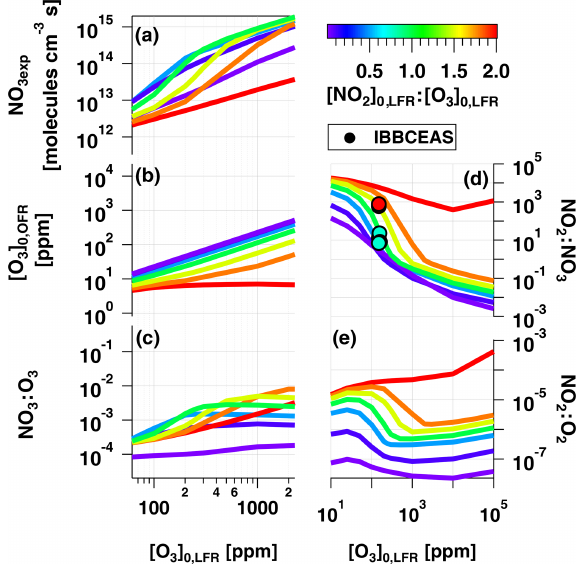
Figure 7. Modeled (a) NO 3exp , (b) [O 3 ], (c) NO 3 : O 3 ,